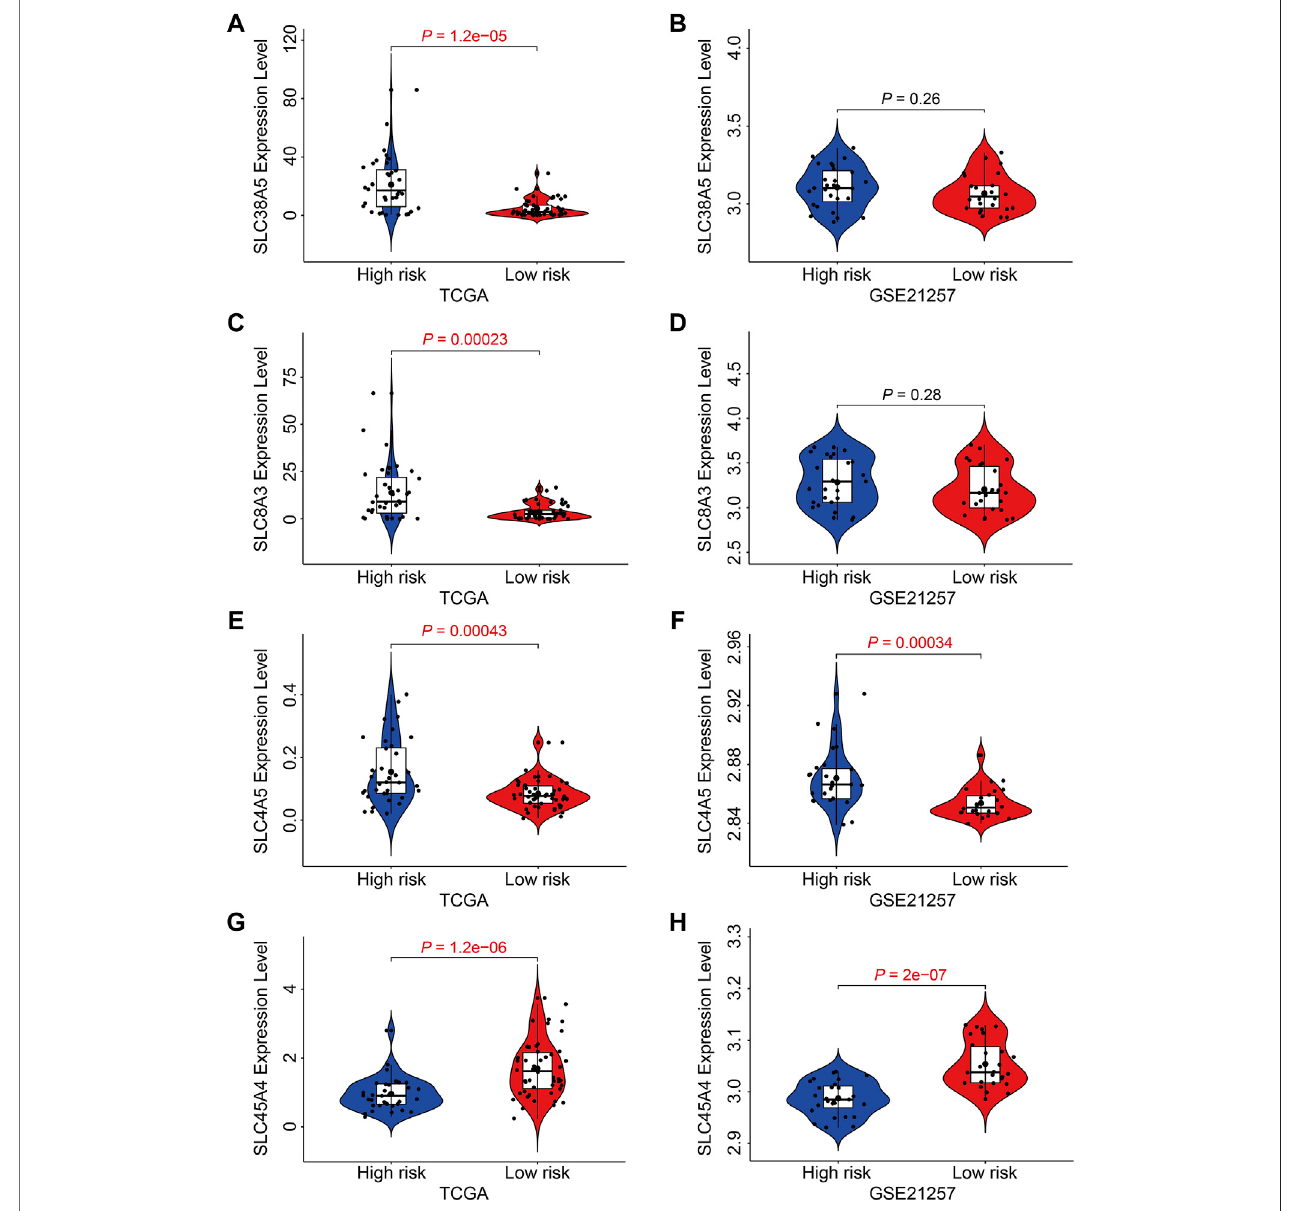
FIGURE10| ExpressionanalysisofthefourSLCgenesinhigh-andlow-riskgroups. (A,B) Theexpressionof SLC38A5 inTCGAandGSE21257cohort. (C,D) The expression of SLC8A3 in TCGA and GSE21257 cohort. (E,F) The expression of SLC4A5 in TCGA and GSE21257 cohort. (G,H) The expression of SLC45A4 in TCGA and GSE21257